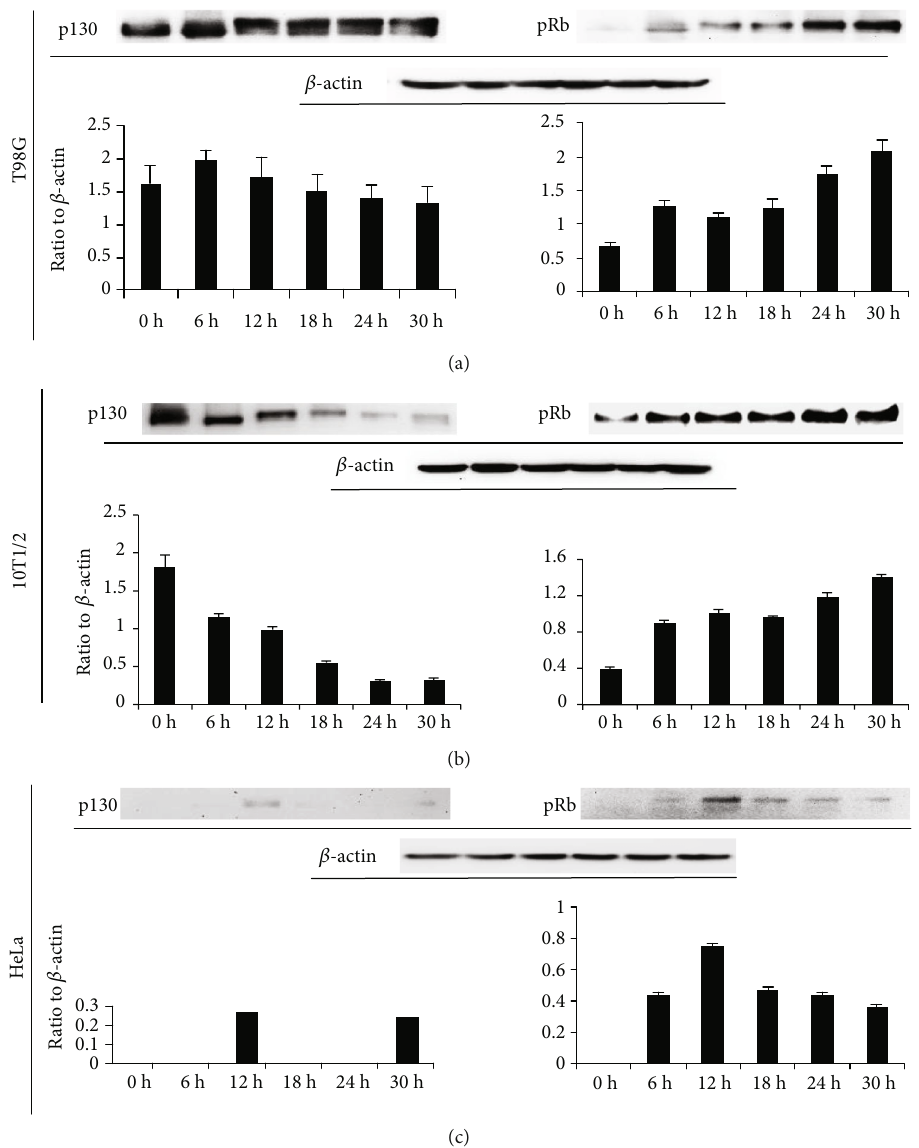
Figure 2: Western blotting analysis of the p130 and pRb cell cycle-dependent oscillations in 10T1/2, T98G, and HeLa cell lines. The cells of all cell lines were synchronized as described above. The cell extracts containing 40 μ g of total protein were resolved on 8% SDS – PAGE for the following Western blotting: (a) T98G cell line; (b) MSCs (10 T1/2 cell line); (c) HeLa cell line. The data are presented as mean ± SD